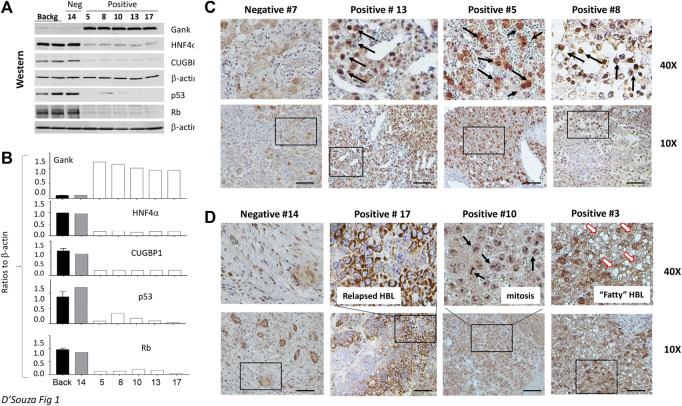
Gank-TSPs pathway is activated in the majority of hepatoblastoma samples that are characterized by chemo-resistance and by severe disease. (A) Western blotting analysis of expression of Gank and TSPs in nuclear extracts of background regions, Gank negative (#14), and Gank positive HBLs. (B) Bar graphs show quantitation of protein levels as ratios to β-actin. (C) Gank immunohistochemistry for patients with Gank overexpression compared to patients with no Gank overexpression. The elevated Gank is observed in nuclei of HBL patients. Arrows show nuclear Gank. (D) Examples of Gank staining in HBL samples with other pathological abnormalities. Arrows show mitotic figures in sample 10 and fat droplets in sample 3.